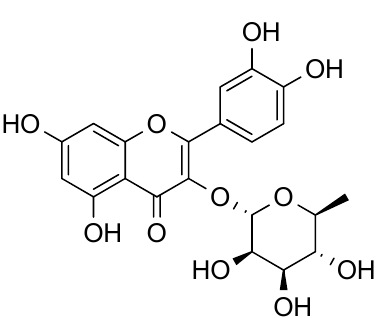
Figure 7. Structure of